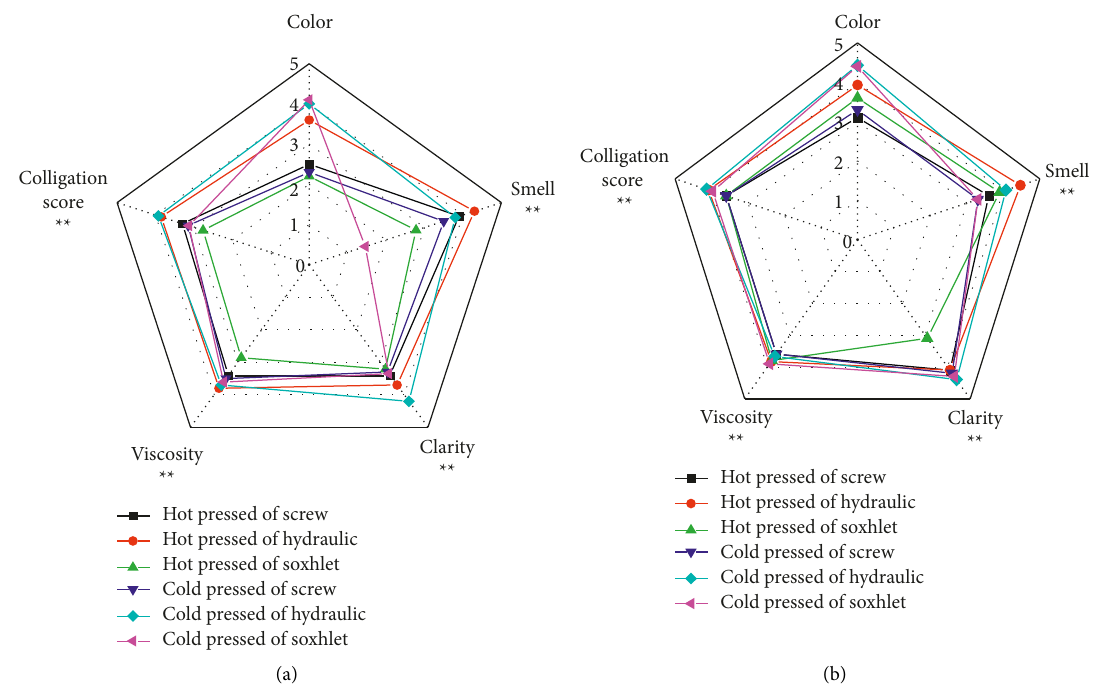
Figure 2: Sensory scores of rapeseed oil and flaxseed oil extracted by different extraction methods. (a) Rapeseed oil and (b) flaxseed